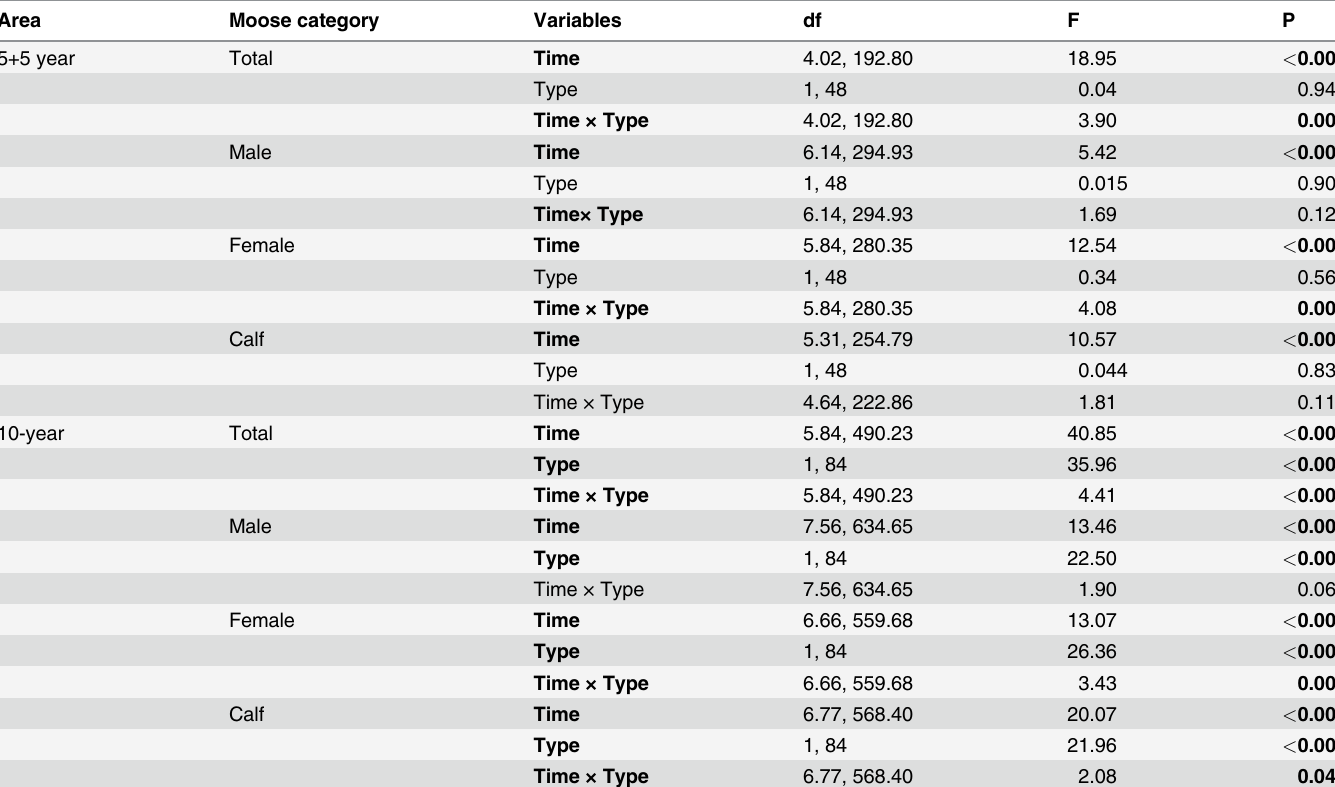
Table 1. Effects of time (ten-year periods) and type of area (wolf territories and control areas) on hunter harvest of moose (total number of moose harvested as well as number of males, females and calves), using a general linear model with the repeated measures options.